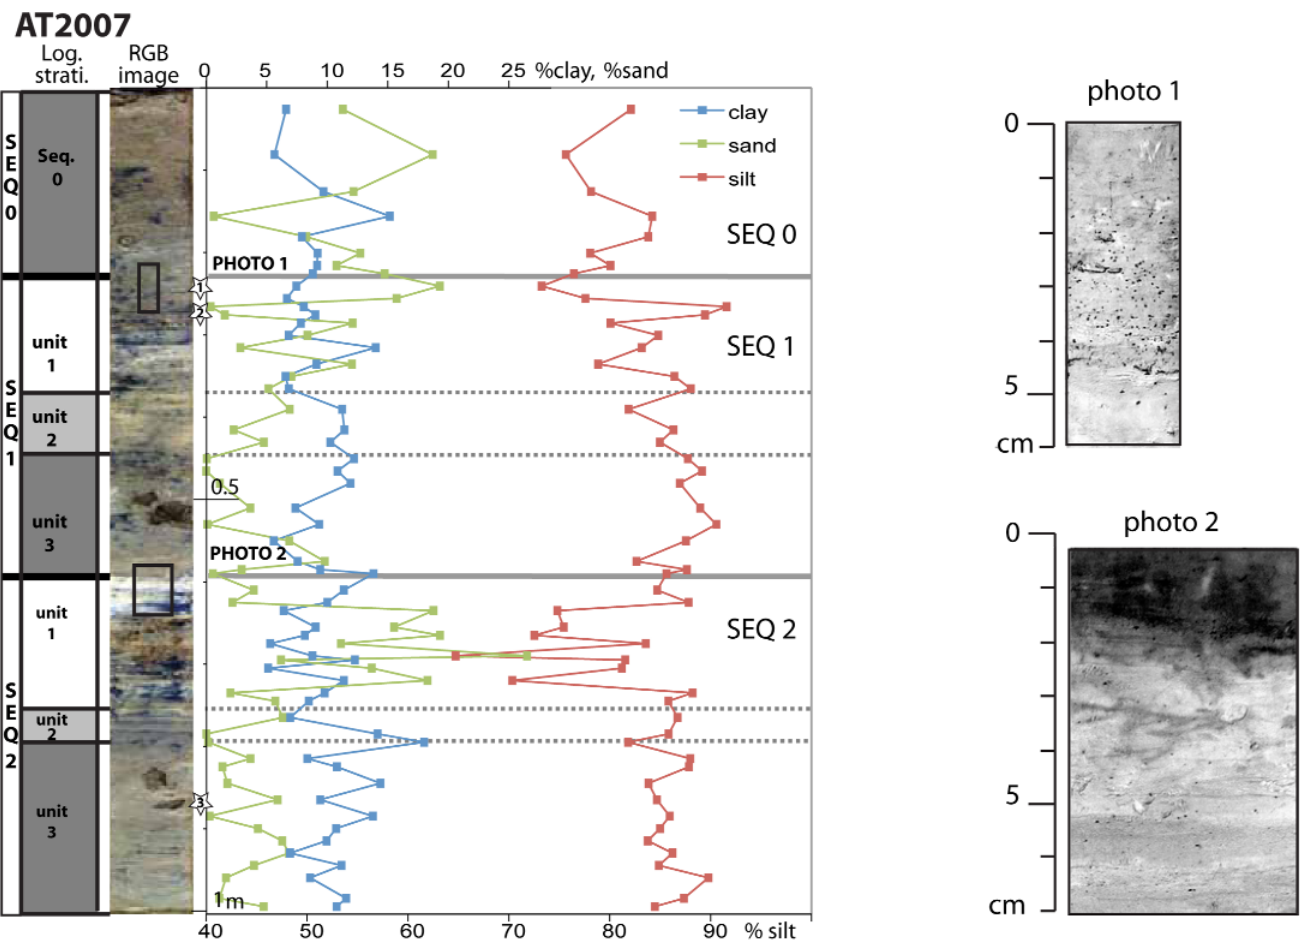
Figure 6. Granulometry of core AT2007. Left: stratigraphic log; right: percentage of clay, silt, and sand particles. Photos of the top of units 1 in sequences 1 and 2 are shown on the right, with their vertical scale. Stars indicate location of sieved samples in Figure